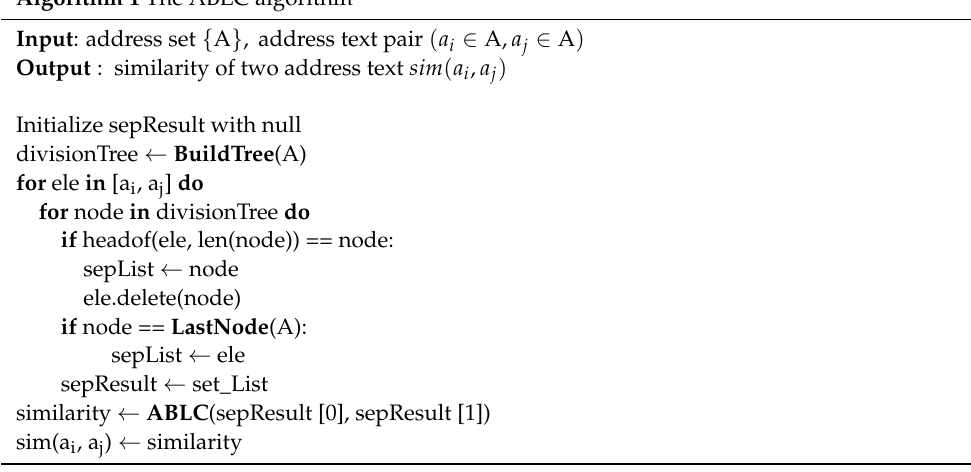
Algorithm 1 The ABLC